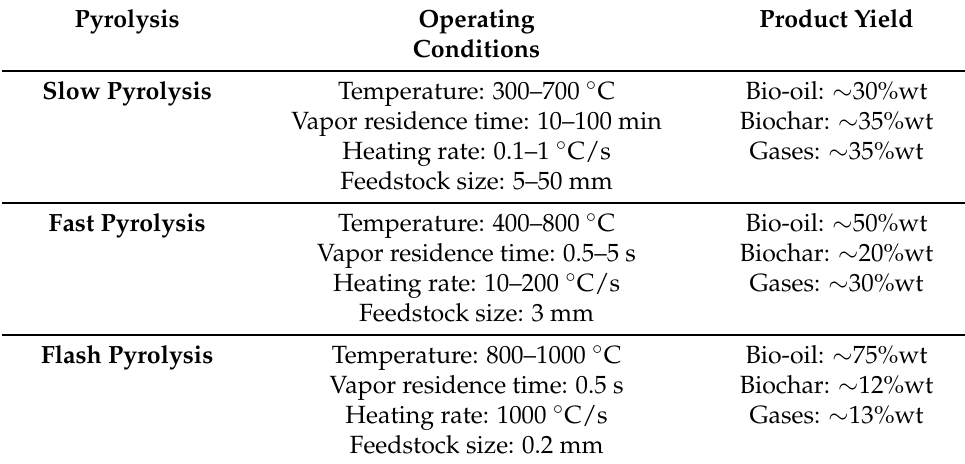
Table 1. Outcomes of pyrolysis obtained from various pyrolysis technologies